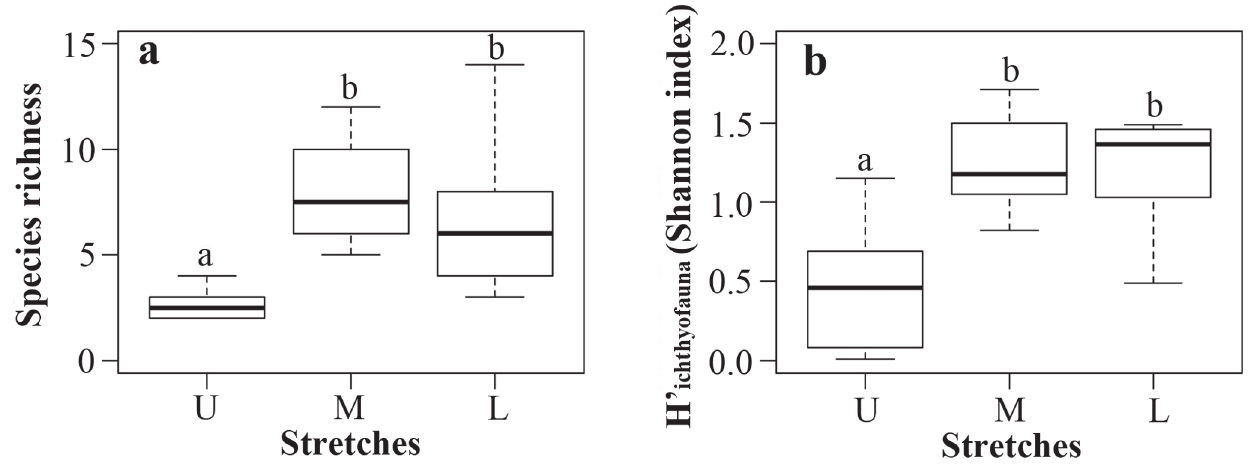
Fig. 2. Box-plots showing median (thick lines), first, and third quartiles (boxes), minimum and maximum values (whiskers) to upper (U), middle (M) and lower (L) stream stretches, according to ichthyofauna richness (A) and ichthyofauna diversity (B) in Jureia-Itatins Ecological Station. Different letters above each box-plot represents p < 0.05 to post-hoc tests, and same letters represents p >